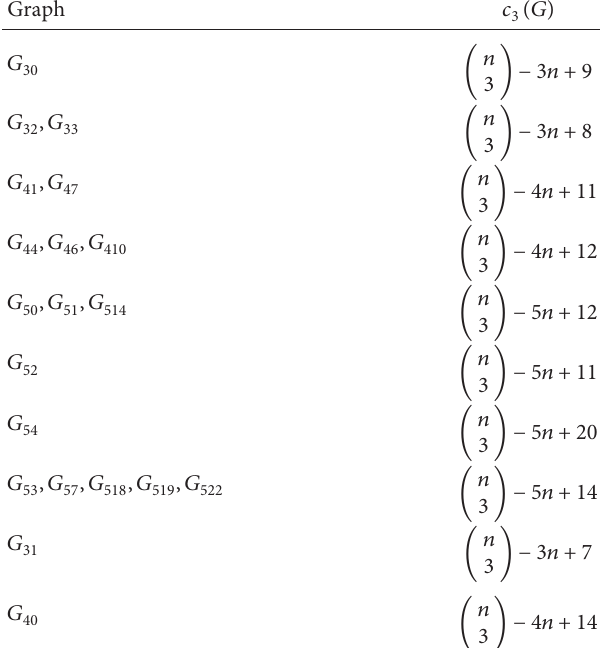
n by deleting five or fewer edges drawn as lines in a disk. n . ( G 3